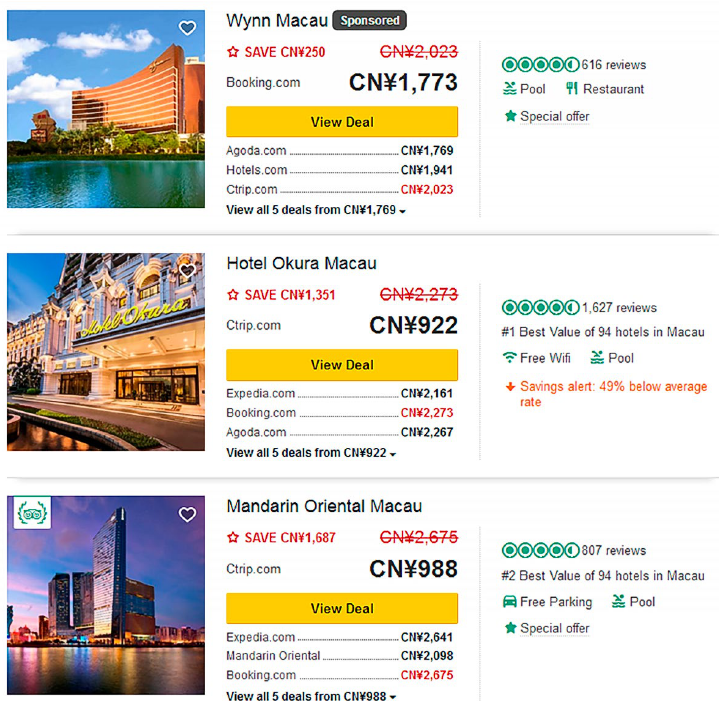
Figure 1. A list of tourism hotels in Macao from